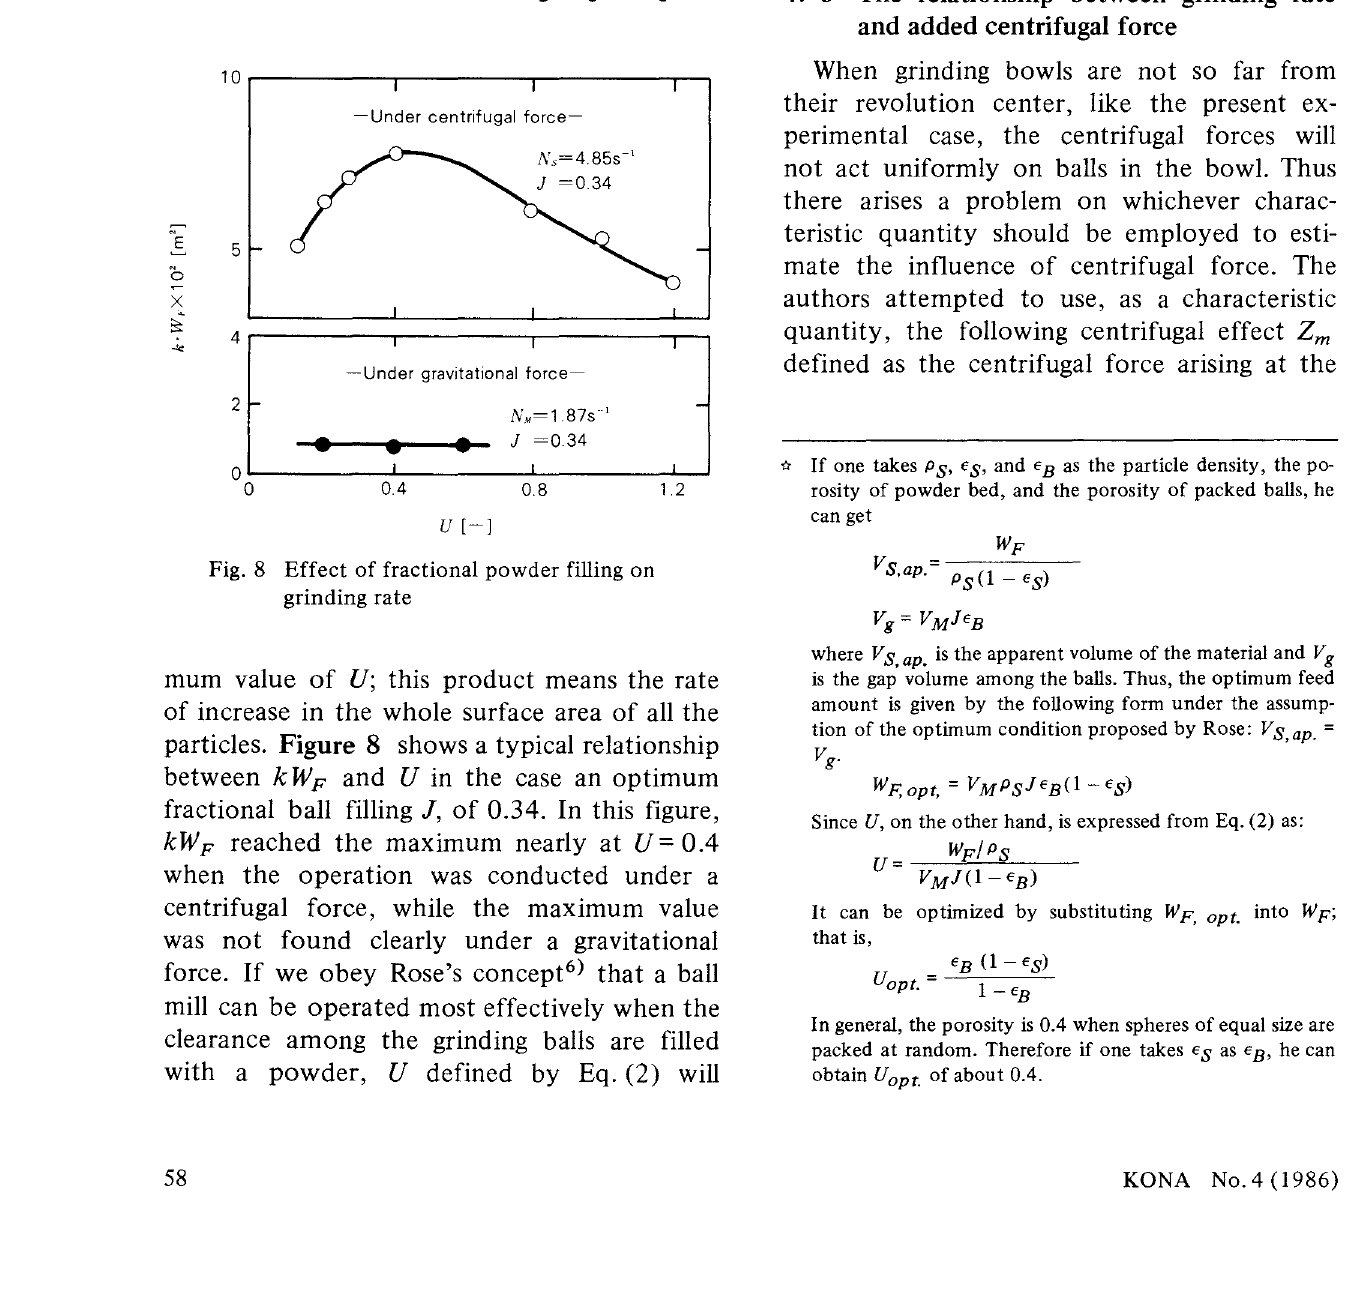
Fig. 7 Effect of fractional ball filling on grinding rate